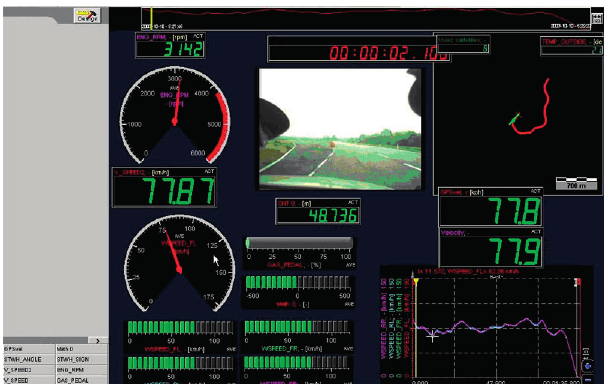
Figure 4. Graphical interface of the Dewetron testing system.